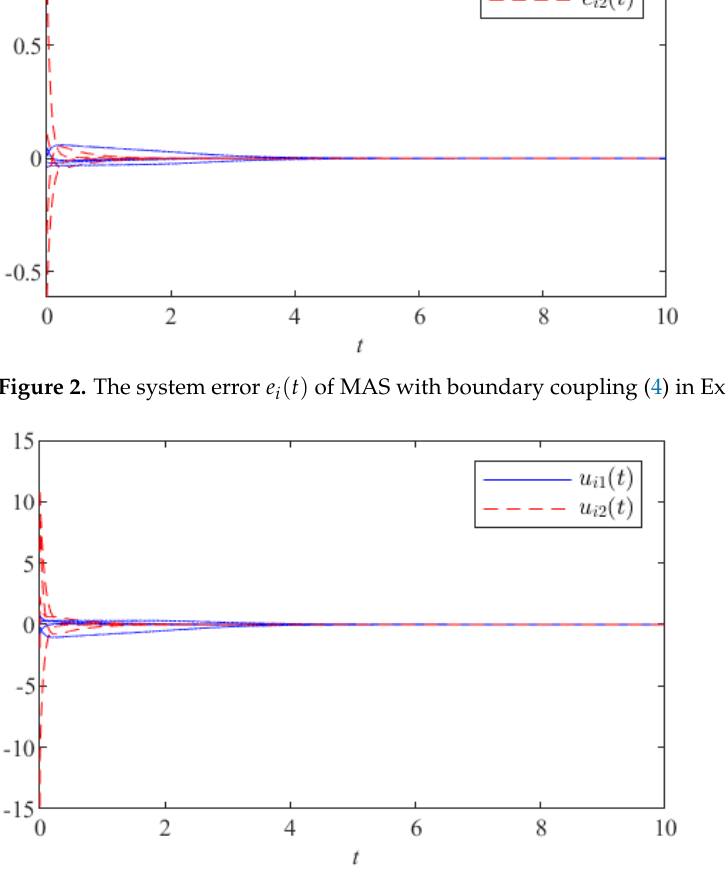
Figure 3. The boundary coupling u i ( t ) in Example